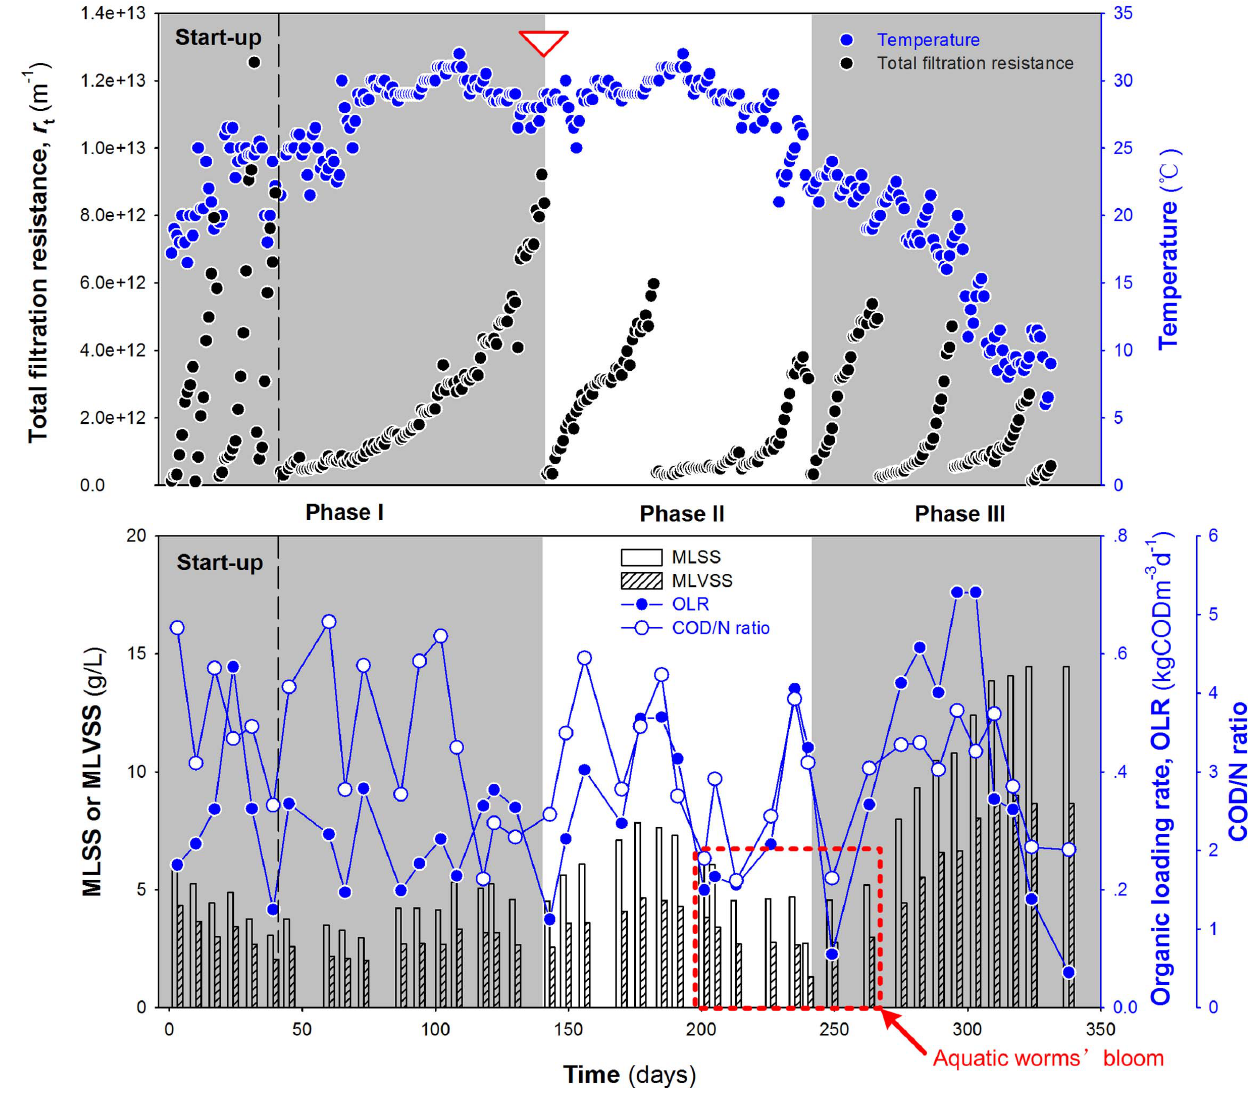
Figure 2. Variations in r t , biomass concentration, OLR and COD/N ratio during R 0 operation. (The inverted open triangle indicates the time point of sludge